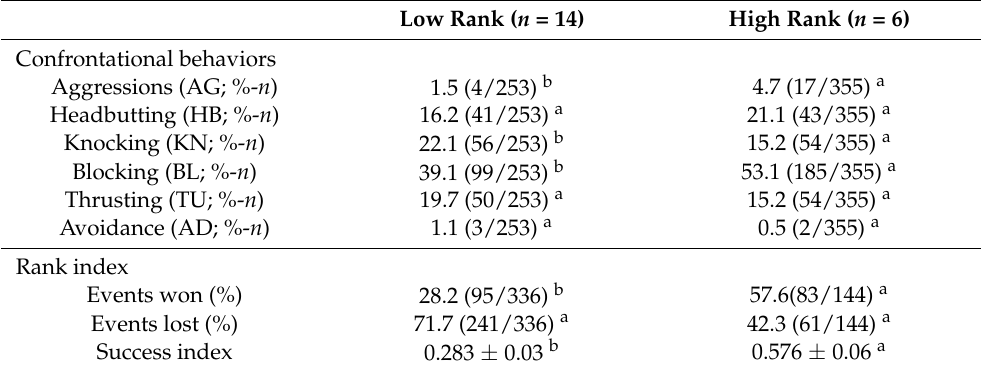
Table 1. Confrontational behaviors of well-fed adult Dorper rams recorded during the competition test used to measure the Success